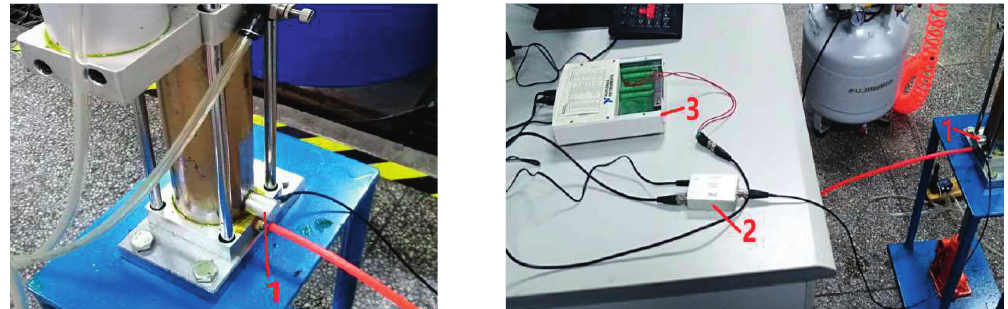
Figure 4: (a) Image of the AE sensor. (b) Image of the data acquisition